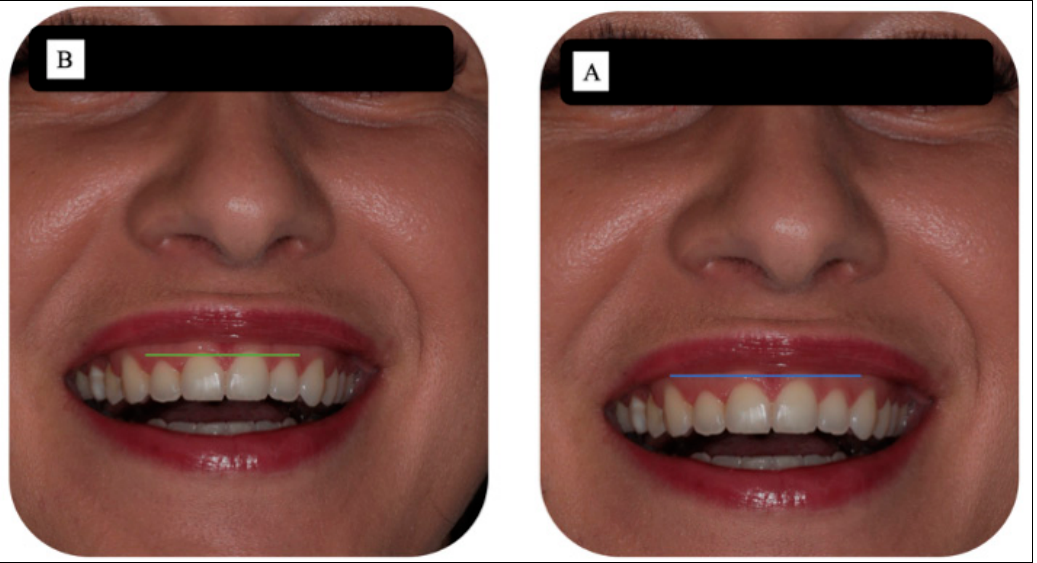
Figure 10. ( A , B ) . At six-months post-laser treatment, photo ( A ) illustrates the level of the zeniths (blue line) of the gingival tissue of #11 and #21, whereas photo ( B ) illustrates the level of the zeniths (green line) of the gingival tissue of #12 and #22. The photos show an improvement in the clinical outcomes from an aesthetic standpoint.